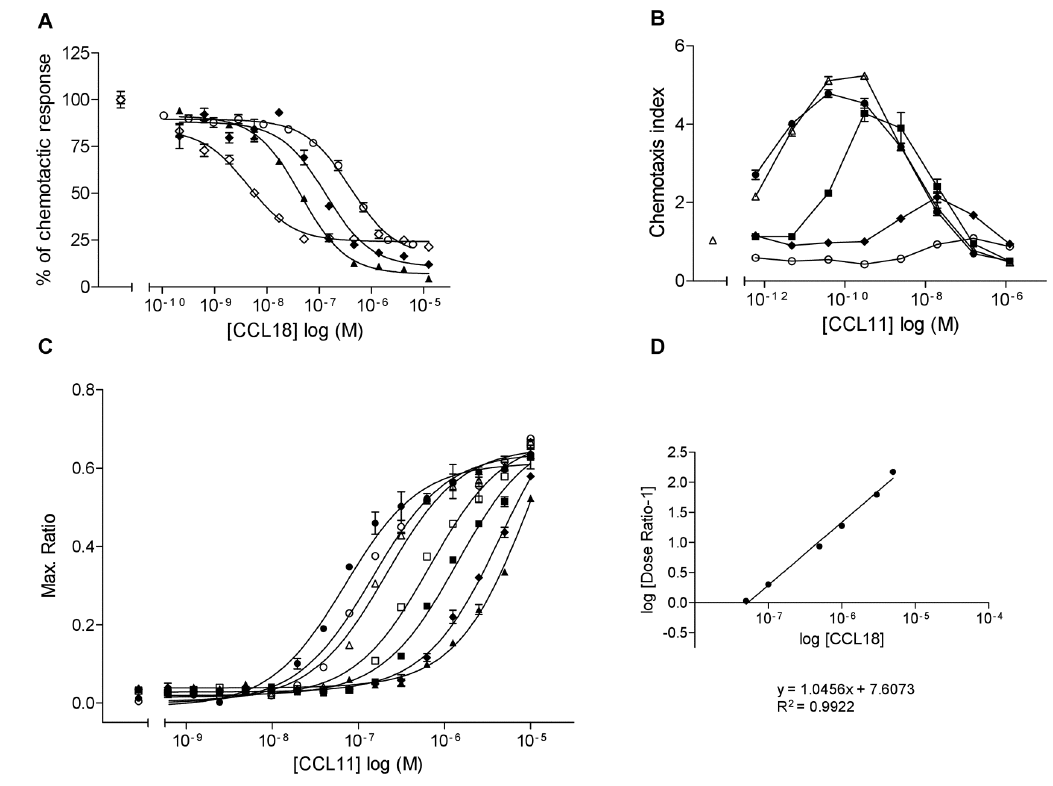
Figure 1. CCL18 inhibits chemotactic responses induced by several CCR3 agonists and behaves as a competitive antagonist in functional studies. A) Inhibition of chemotaxis assay using L1.2/CCR3 transfectants. Chemotaxis inhibition assays were performed using a constant concentration of receptor agonist close to the EC , 1 nM CCL11 (○), 10 nM CCL5 (▲), 100 nM 80 CCL15 (◊) and 10 nM CCL26 (♦) in the presence of an increasing concentration of CCL18. CCL18 inhibits the chemotactic responses induced by CCL5 (IC : 40.79 nM), CCL11 (IC : 396.7 nM), CCL15 (IC : 2.86 nM) and CCL26 (IC : 123.4 nM). Data are 50 50 50 50 expressed in % of chemotactic response. Data points are in triplicate. The number of experiments is indicated in Table 1. B) CCL18 inhibits CCL11-induced chemotactic responses of L1.2/CCR3 transfectants. Inhibition of chemotaxis was performed using a dose– response of CCL11 (●) in the presence of a constant concentration of 100 nM (Δ), 1 µM (■), 10 µM (♦) and 40 µM (○) CCL18. Data points are in triplicate. Data are expressed as mean ± SEM. One representative experiment out of two is shown. C) Ca 2+ mobilization assay in L1.2/CCR3 transfectants after stimulation with a dose response of CCL11 (●) in the presence of a constant concentration of 50 nM (○), 100 nM (Δ), 500 nM (□), 1 µM (■), 3 µM (♦) and 5 µM CCL18 (▲). The presence of CCL18 resulted in an increase the EC of the CCL11-induced Ca 2+ release in a concentration dependent manner: 0 nM CCL18 (EC : 69.93 nM), 50 50 50 nM CCL18 (EC : 144.4 nM), 100 nM CCL18 (EC : 210.6 nM), 500 nM CCL18 (EC : 669.5 nM), 1 µM CCL18 (EC : 1395 nM), 50 50 50 50 3 µM CCL18 (EC : 4439 nM), 5 µM CCL18 (EC : 10530 nM). Data points are in duplicate. One representative experiment out of 50 50 two is shown. D) Investigation of the effect of CCL18 on CCR3-mediated cellular responses by Schild regression analysis. The EC 50 values obtained in Ca 2+ mobilization studies were used to calculate dose ratios. The dose ratios obtained were plotted as a regression of log (dose ratio -1) versus log of molar concentrations of the antagonist CCL18. The results revealed that CCL18 is compatible with a competitive type of antagonism. One representative experiment out of two is